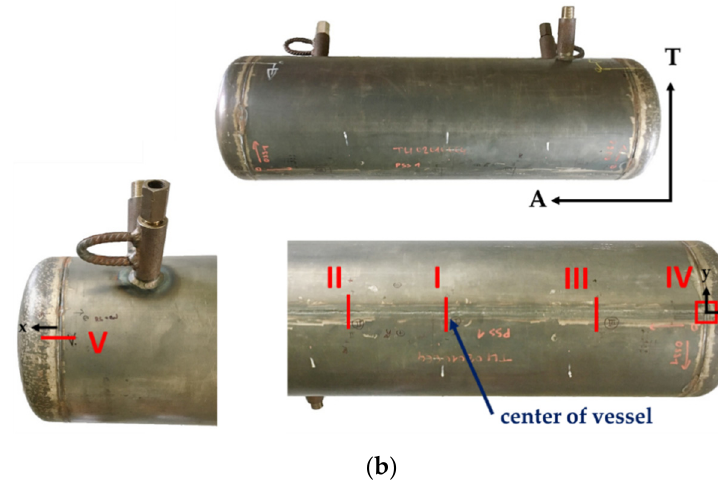
Figure 1. ( a ) Scheme of the plate and ( b ) the pressure vessel model with analyzed areas and direc- tions.